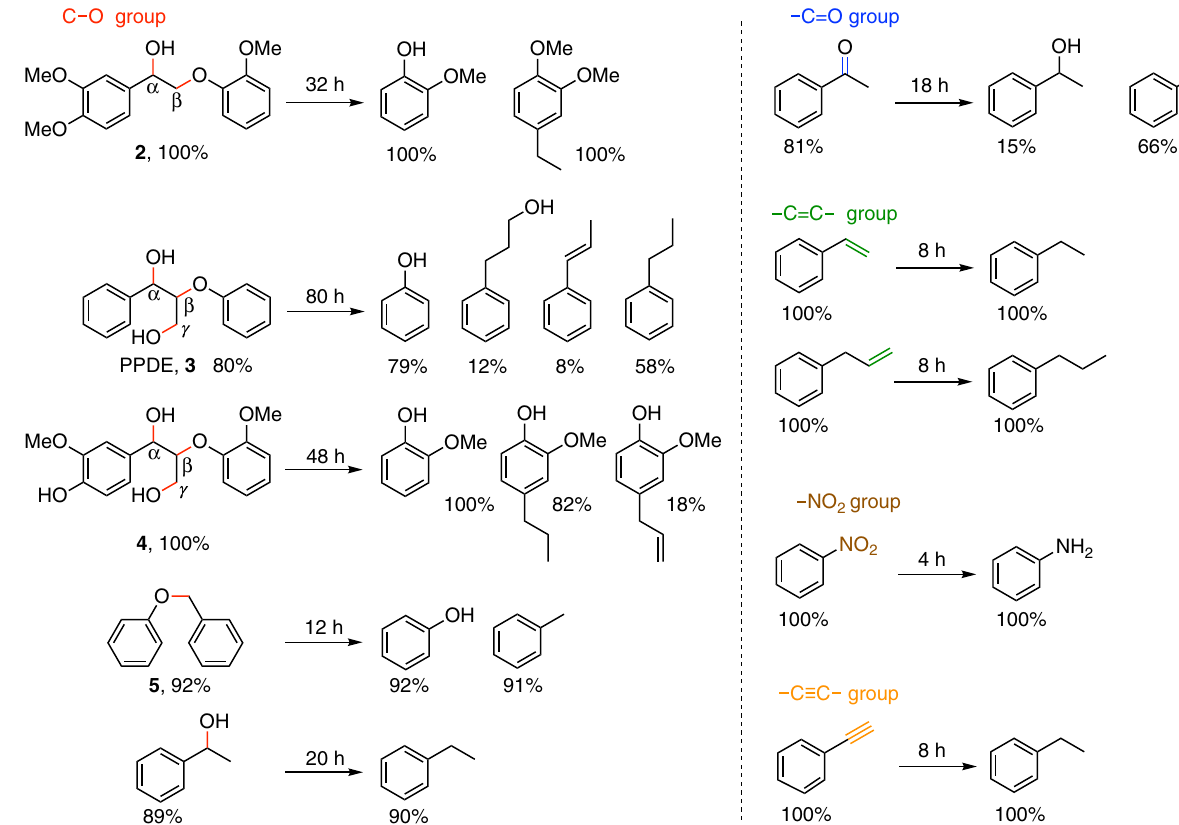
Fig. 3 Reactions of substrates with different functional groups over the NAC-800 catalyst. Conversions and molar yields are shown below each substrate and corresponding products, respectively. Reaction conditions: 14-mmoL − 1 substrate in 2-PrOH (1.50mL), NAC-800 (5.0 mg), 230°C, 20-bar H 2 .